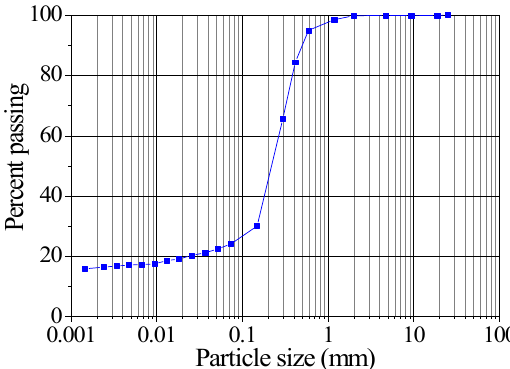
Figure 5 - Grain-size distribution of the slightly clayey fine